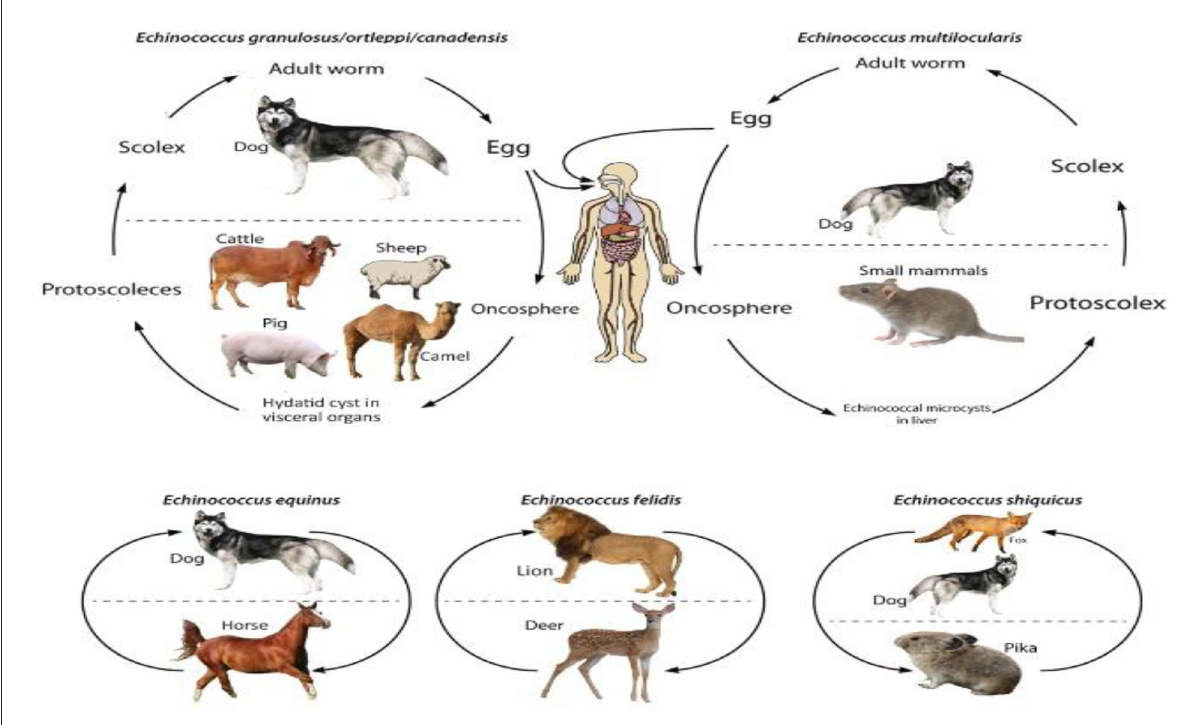
FIGURE2 Life cycle of Echinococcus species.